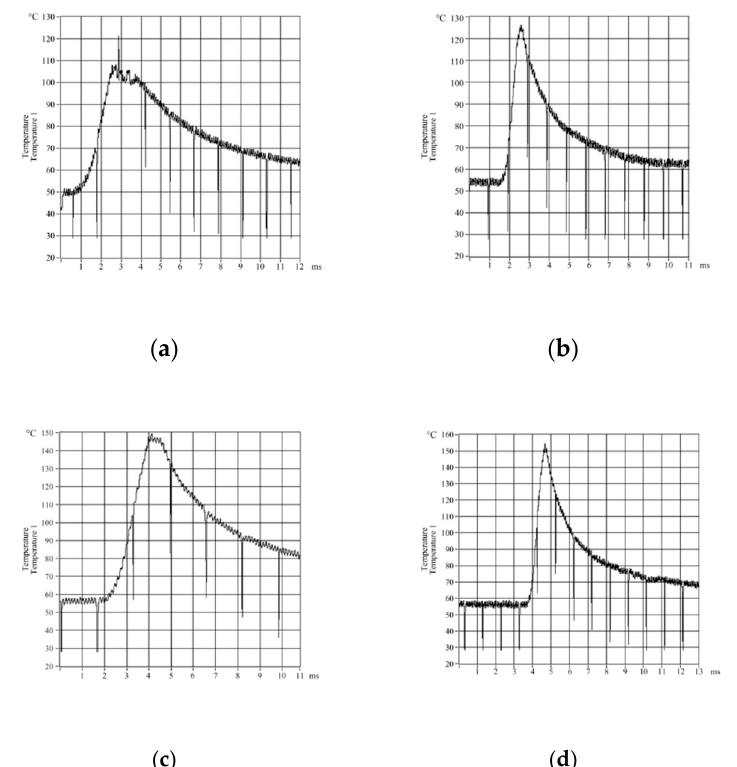
Figure 3. Curves for changes of milling temperature over time at different feed rates. ( a ) f = 0.04 mm/z; ( b ) f = 0.06 mm/z; ( c ) f = 0.08 mm/min; ( d ) f = 0.10 mm/z